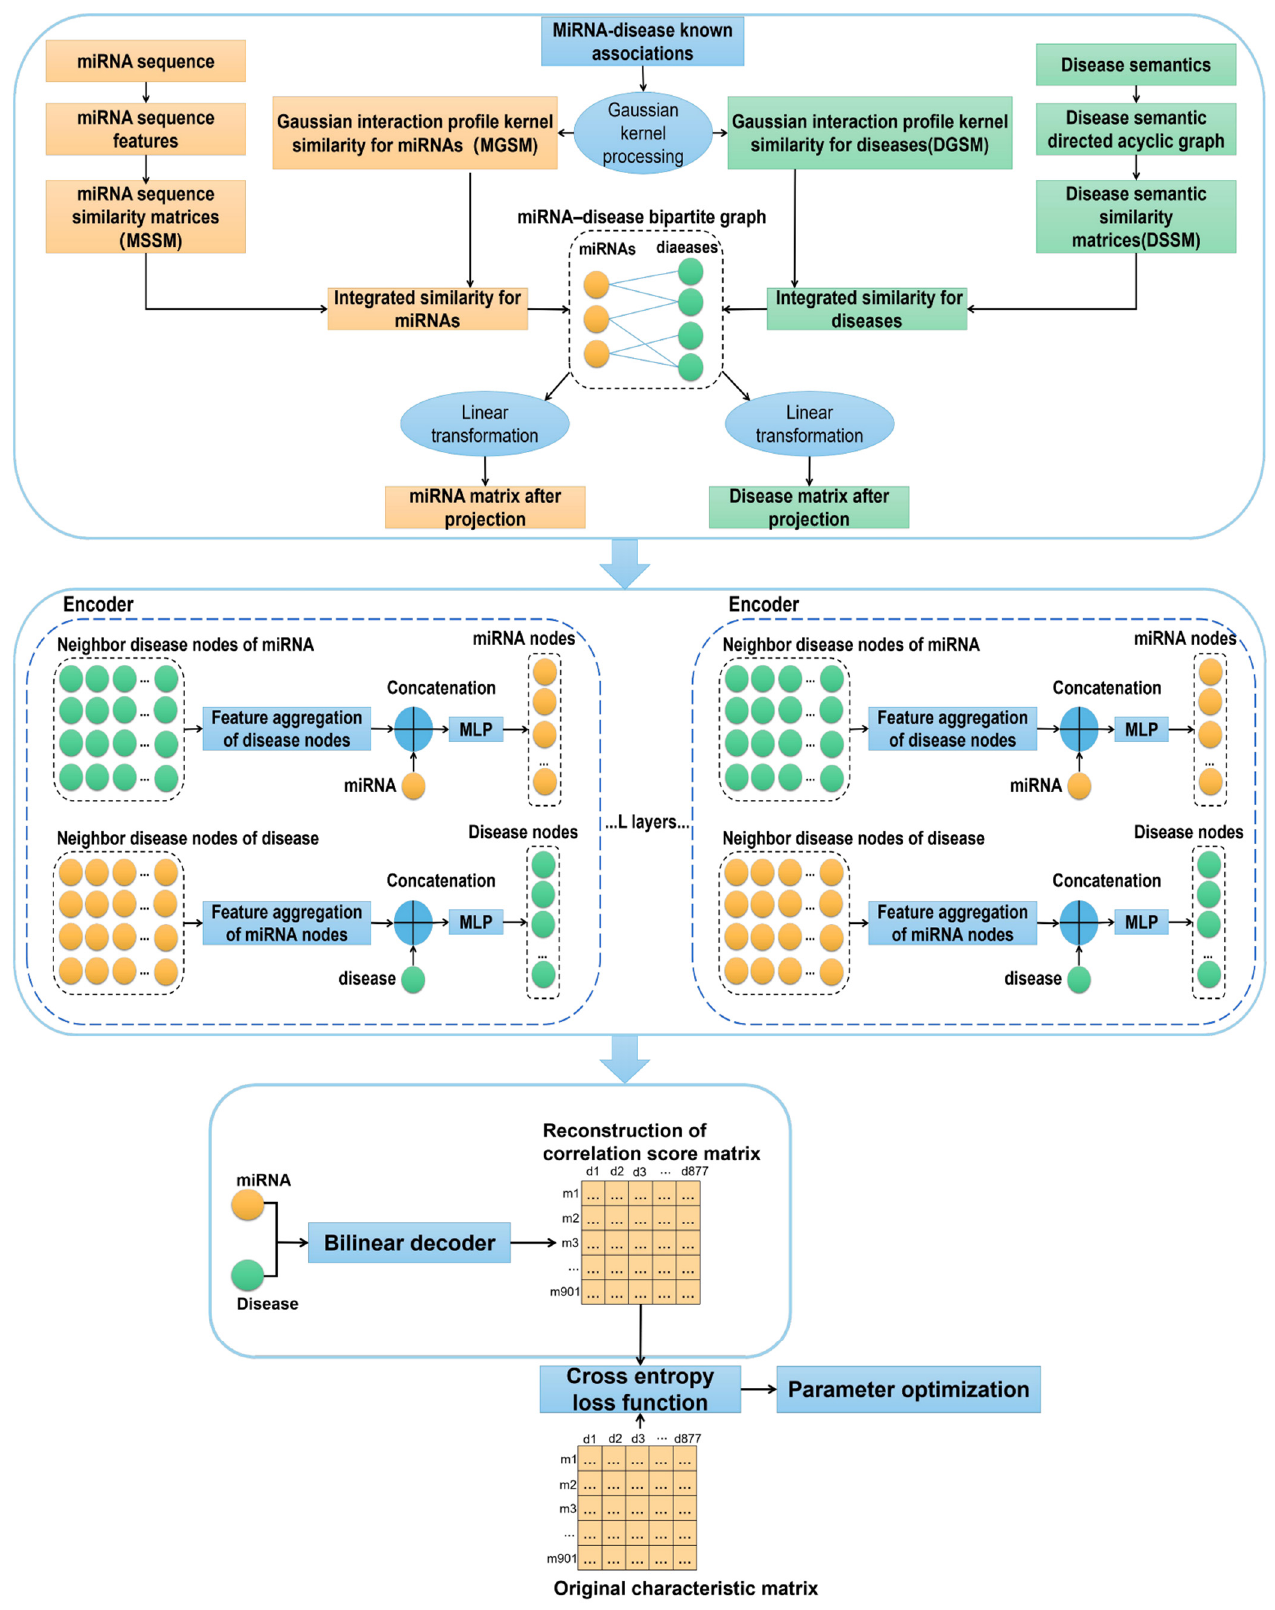
Figure 1. Technical route of miRNA disease correlation prediction model.